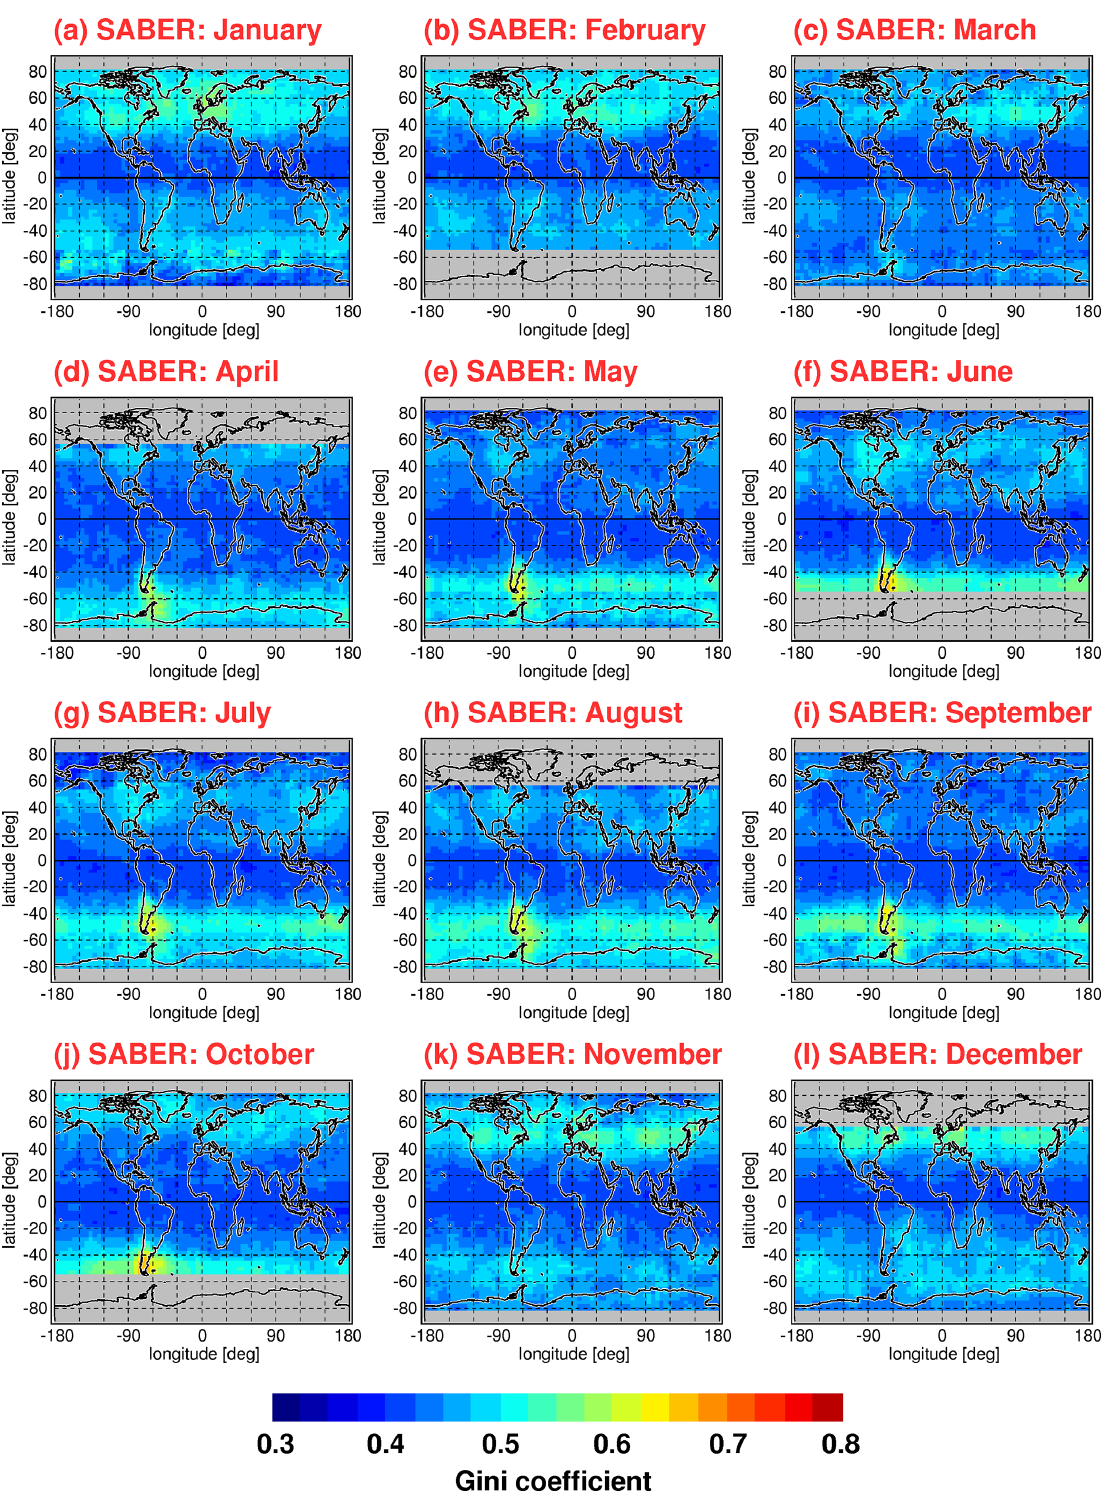
Figure 12. Global distributions of the Gini coefficients for SABER gravity wave potential energies at 30km altitude for each calendar month. Values shown are multiyear means of monthly values determined in overlapping 10 ◦ × 15 ◦ (latitude × longitude) grid boxes. Single E pot values were normalized by the monthly median distribution before calculating the Gini coefficients. The period used for averaging is